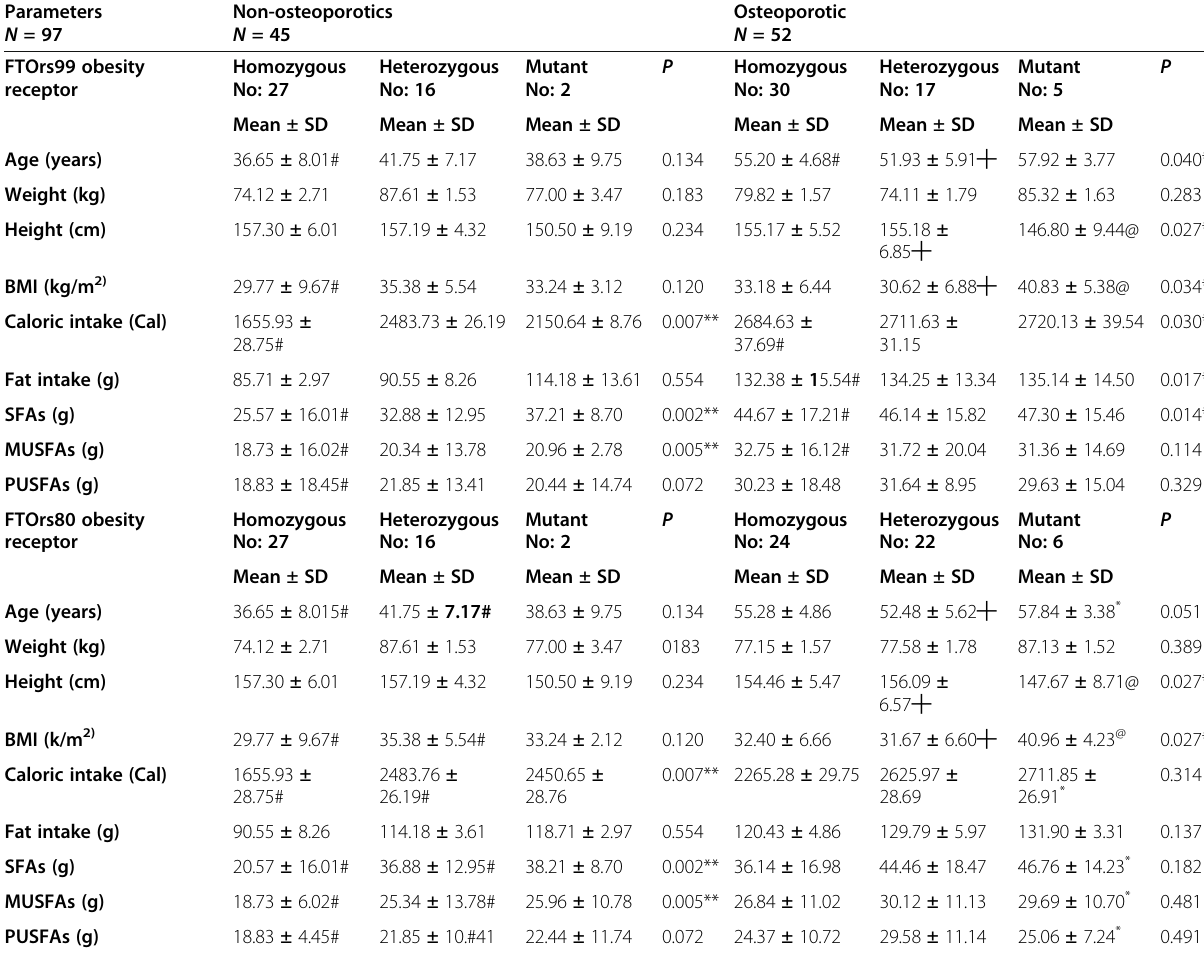
Table 4 Comparison between different studied obesity receptors genes genotypes regarding the related investigated parameters Parameters N =